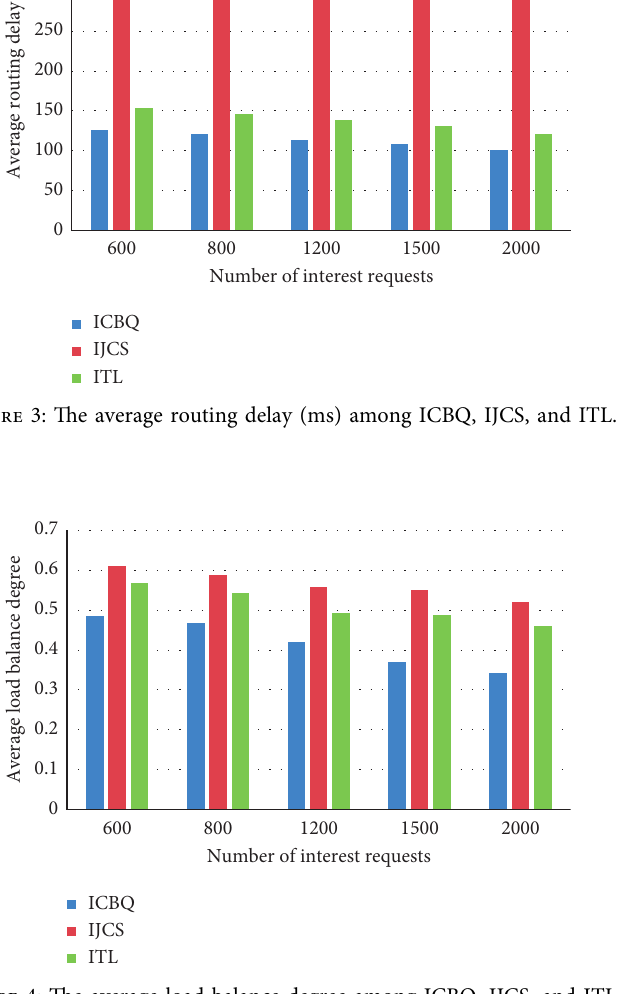
Figure 4: The average load balance degree among ICBQ, IJCS, and ITL.